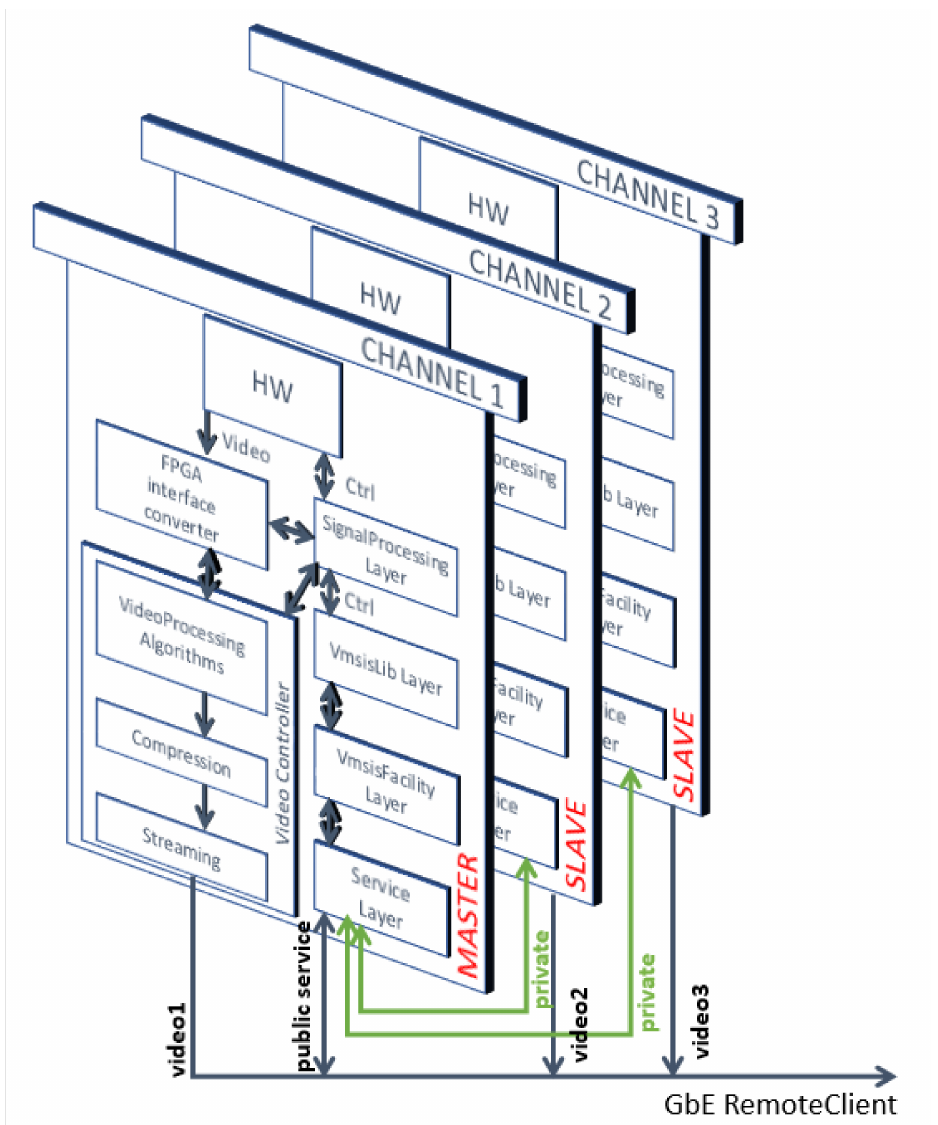
Figure 10. VVSP software